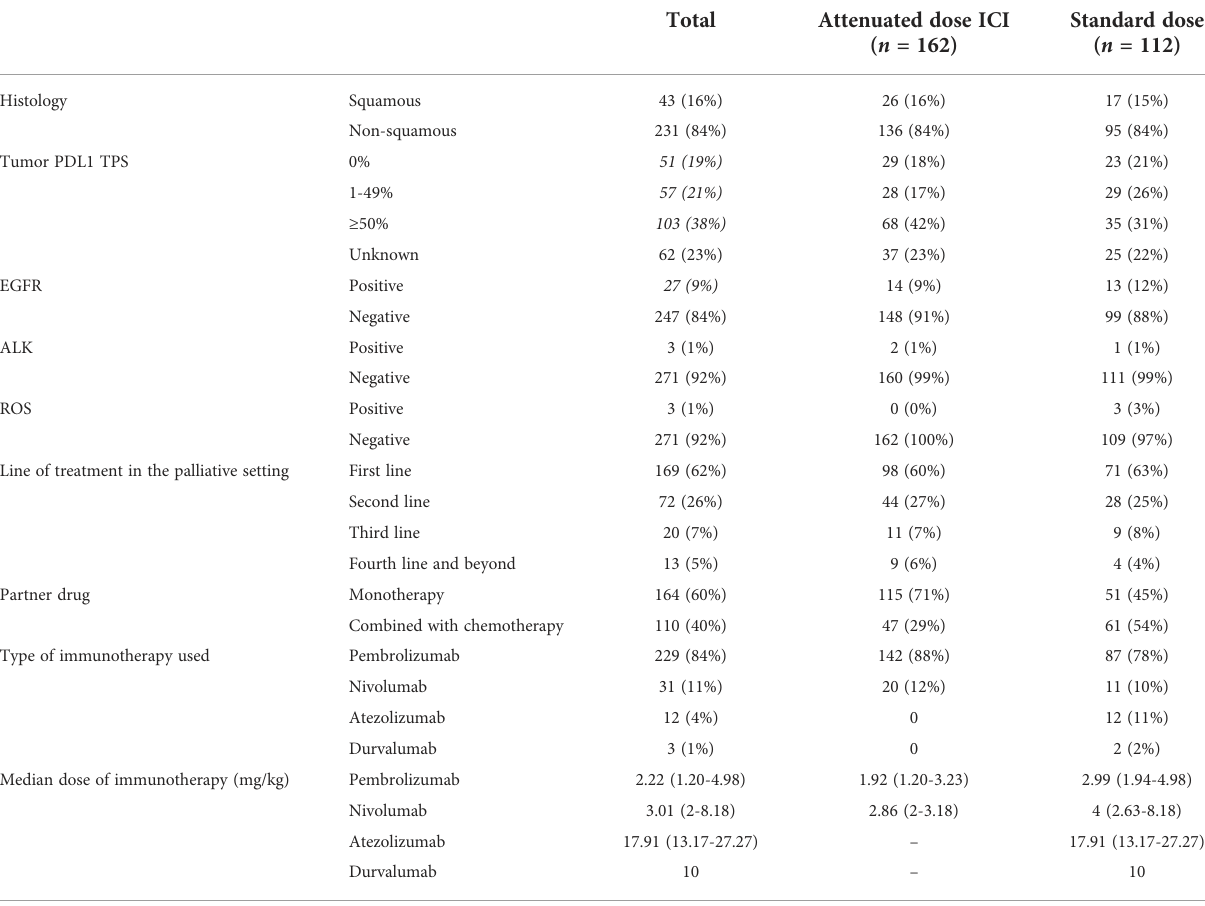
TABLE 2 Treatment